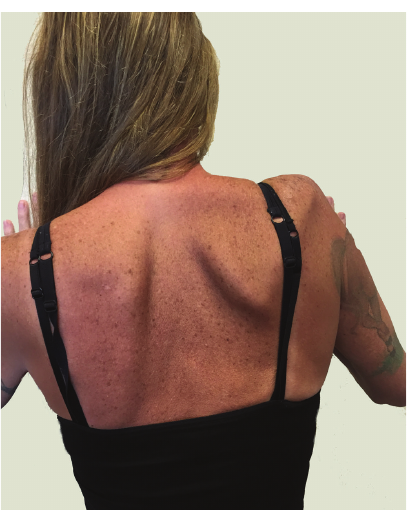
Figure 5: Photo taken 24 months after the index TSA shows the patient’s back while she presses her hands against the wall in front of her. The trapezius atrophy has worsened and the lateral scapular winging is more pronounced than six months prior (Figure